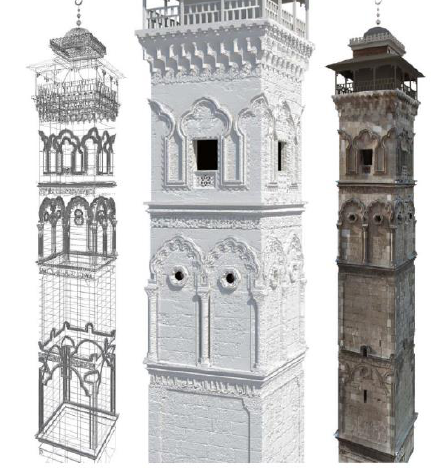
Figure 15. The 3D model of the minaret by Wissam Wabeh.